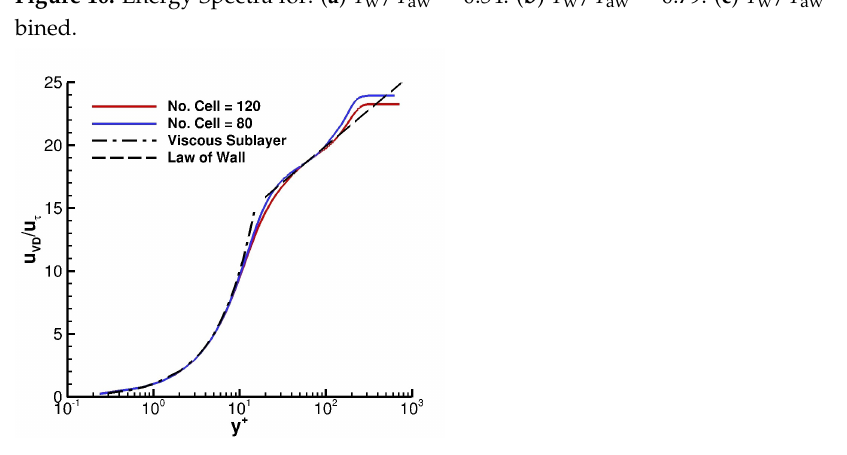
Figure 17. Van Driest transformed mean streamwise velocity at x / δ = 20 for condition No. 2. for two grids with different number of cells in the wall normal